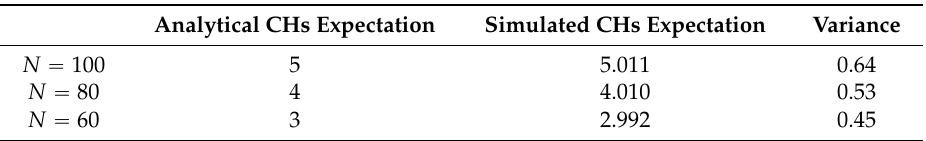
Table 1. The analysis of cluster heads